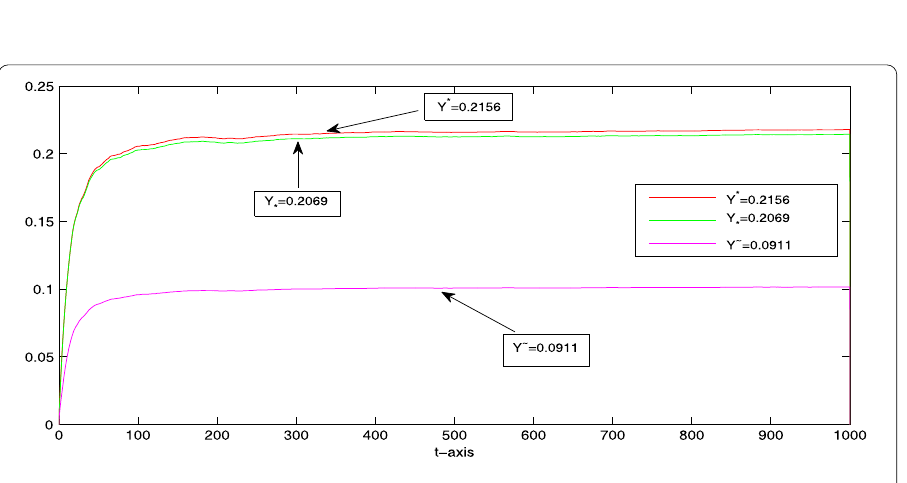
Figure 5 The MESY Y ∗ = 0.2165 of (1.2) when σ 1 = σ 2 = σ 3 = 0.1, γ 1 ( u ) = 0.2, γ 2 ( u ) = 1, γ 3 ( u ) =